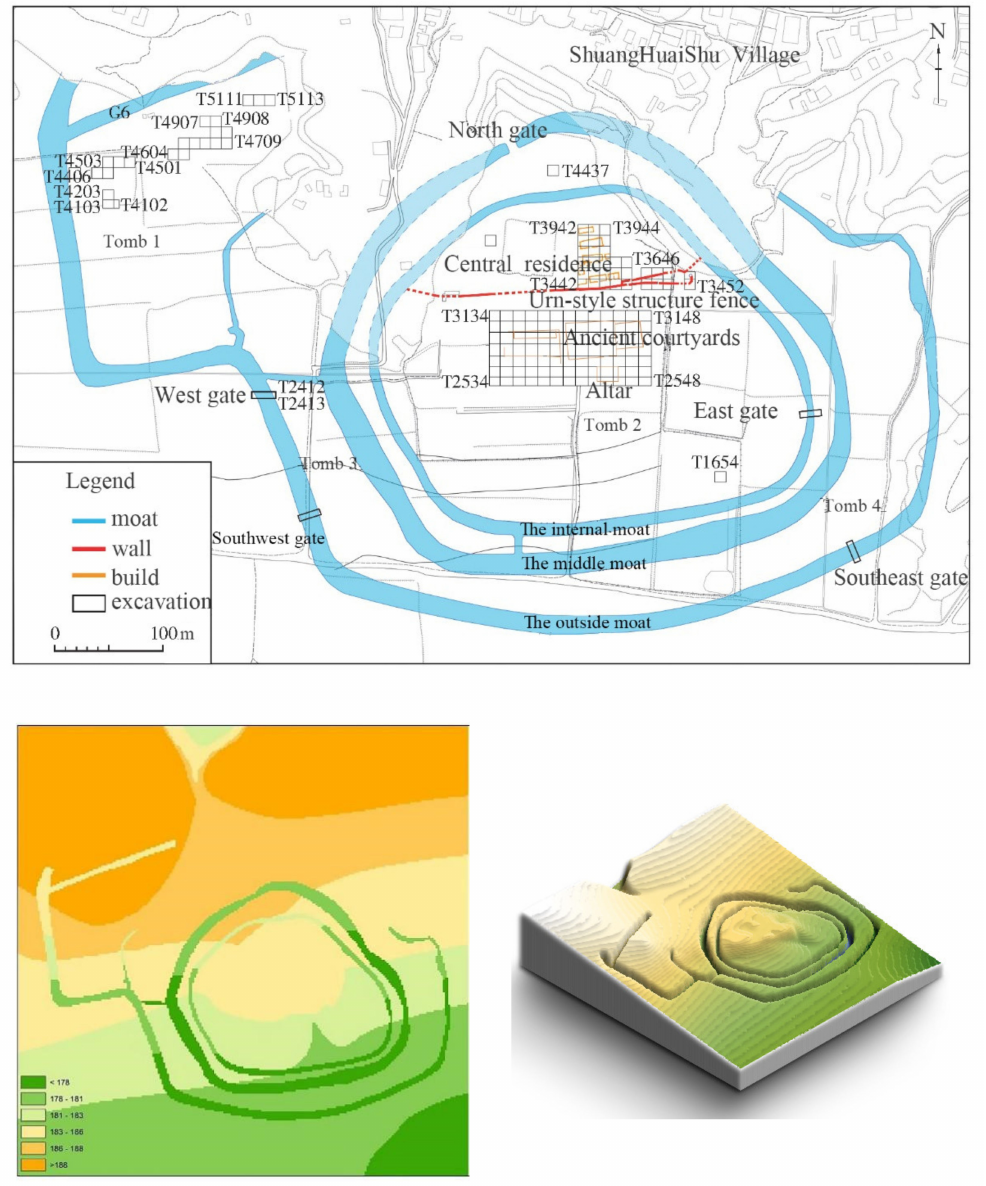
Figure 16. Topographic restoration of the SHS site (the survey and basemap are described in refer- ence